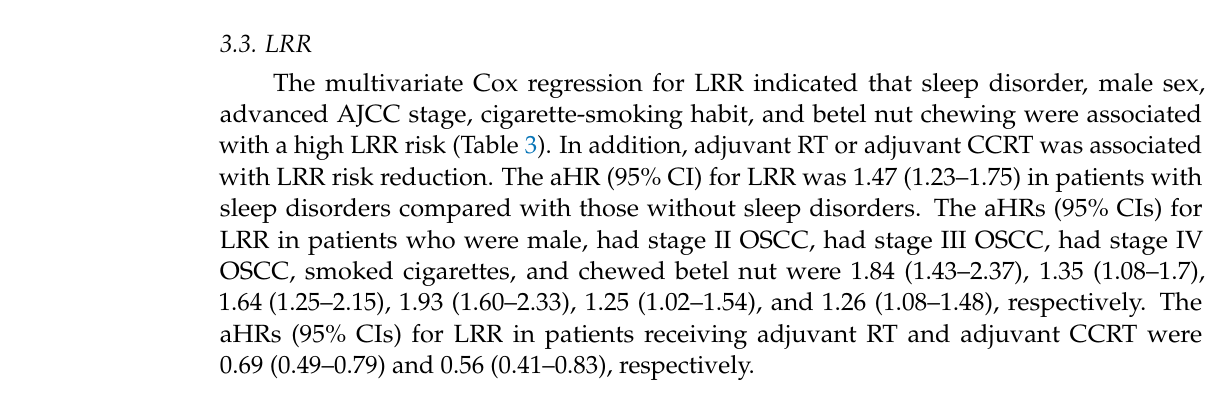
Table 3. Univariable and multivariable Cox proportional regression of locoregional recurrence between patients with oral cavity squamous cell carcinoma with and without sleep